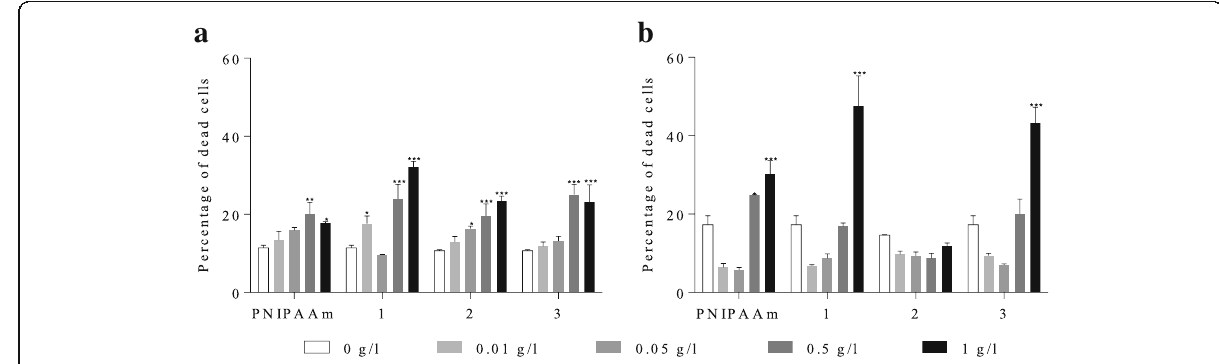
Fig. 6 Percentage of dead Escherichia coli ( a ) and Staphylococcus aureus ( b ) cells after 24-h exposure to PNIPAAm and (1) Fe 3 O 4 -PNIPAAm-1, (2) Fe 3 O 4 -PNIPAAm-2 and (3) Fe 3 O 4 -PNIPAAm-3. Error bars show SD of n = 3. Significance levels * P < 0.05, ** P < 0.005, *** P <